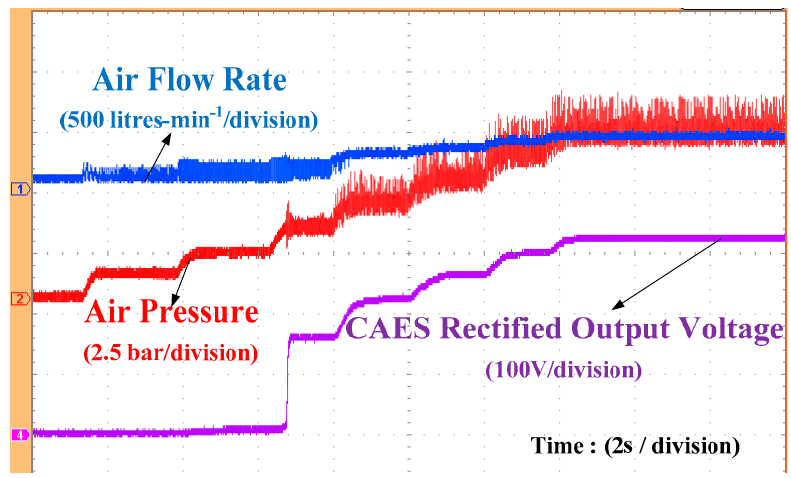
Figure 10. Experimental setup of the grid integrated CAES system.